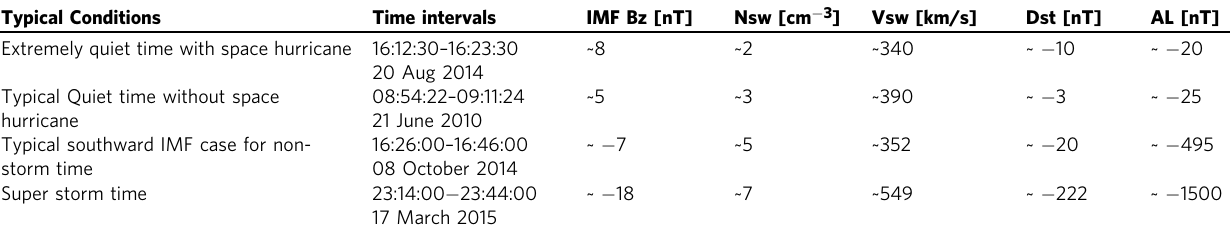
Table 1 The average values of the interplanetary and geomagnetic conditions for four typical conditions. Typical Conditions